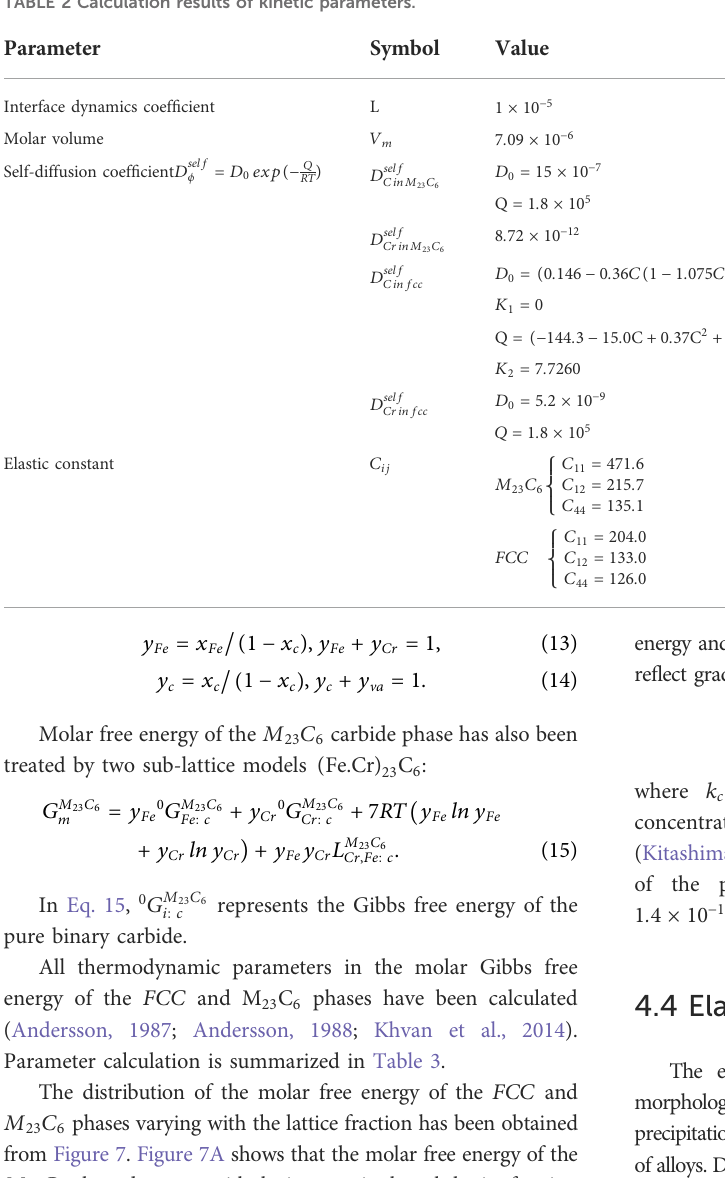
TABLE 2 Calculation results of kinetic parameters.